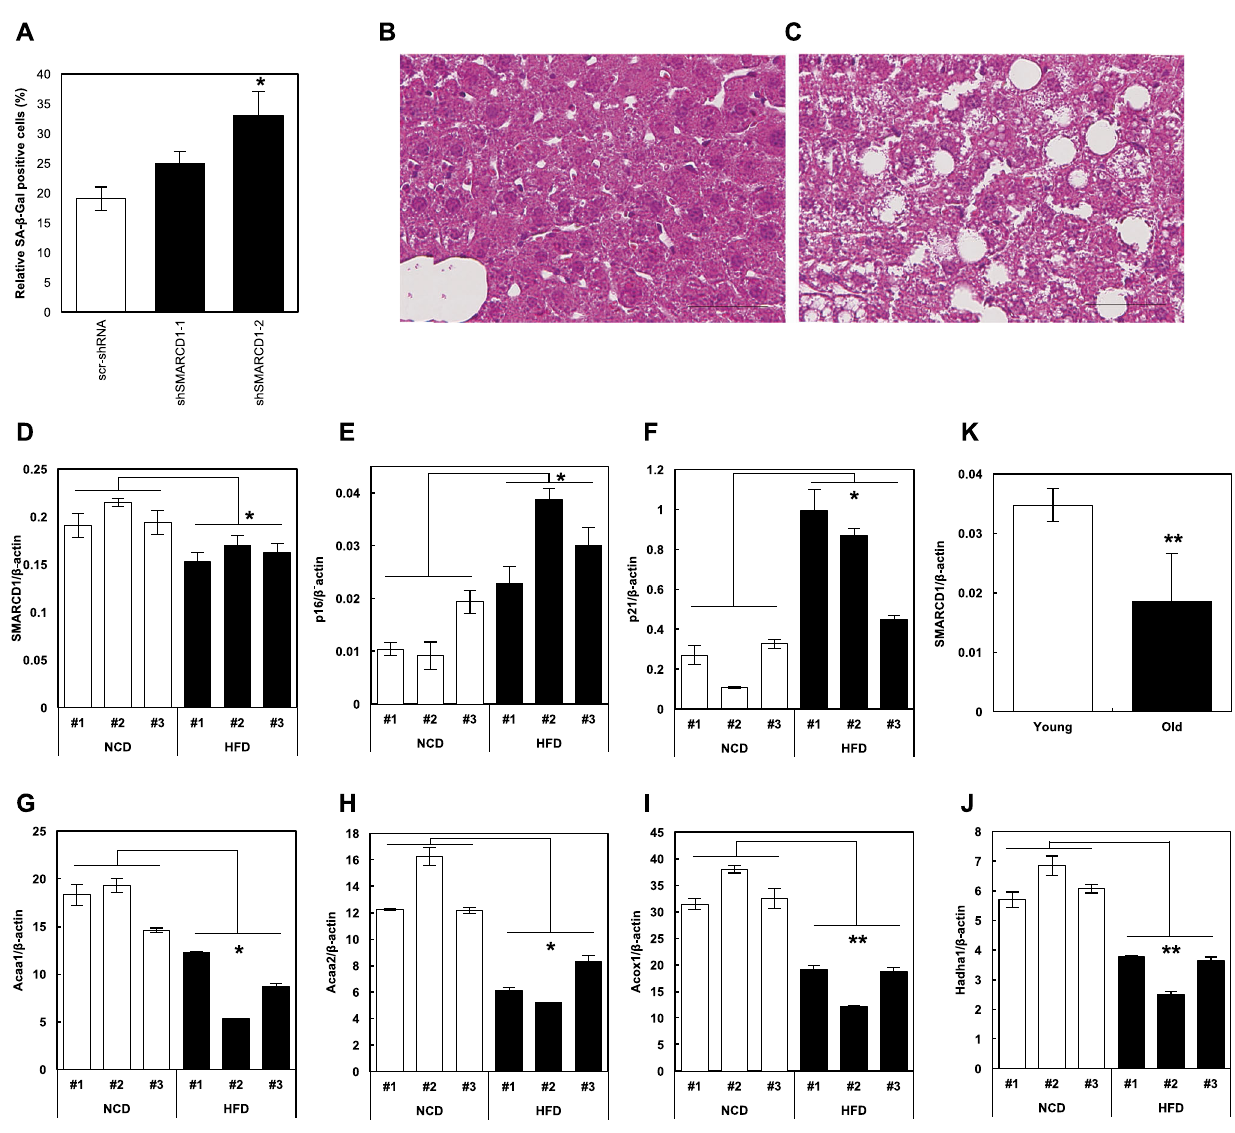
Fig. 5 Smarcd1 roles in high-fat diet-induced hepatic lipid accumulation. ( a ) Senescence induction in scr-shRNA-transduced and Smarcd1- silenced normal mouse primary hepatocytes. Hematoxylin-eosin staining of liver sections obtained from 20-week-old mice fed with normal chow diet (NCD) ( b ) or high-fat diet (HFD) ( c ). Scale bar, 50 μ m. Relative gene expression of Smarcd1 ( d ), p16 ( e ), p21 ( f ), and FAO genes ( g – j ) in livers obtained from NCD or HFD mice. Number indicates the individual mice. ( k ) Relative expression of SMARCD1 gene in peripheral blood mononuclear cells derived from young and old volunteers. Data are expressed as mean ± SD. P < 0.05 was considered statistically signi fi cant ( * P < 0.05; ** P <